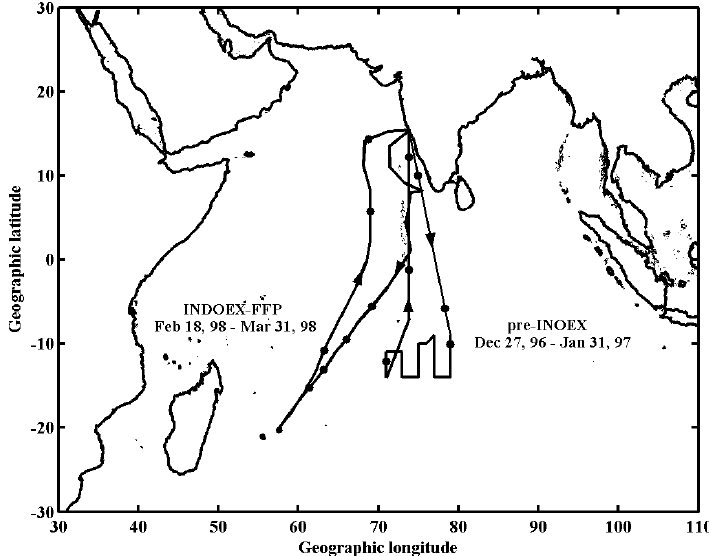
Fig. 1. Map showing the cruise tracks of the pre-INDOEX and INDOEX-FFP. Filled circles along the cruise tracks represent the soundings, which are used in Figs. 2, 3, 6 and